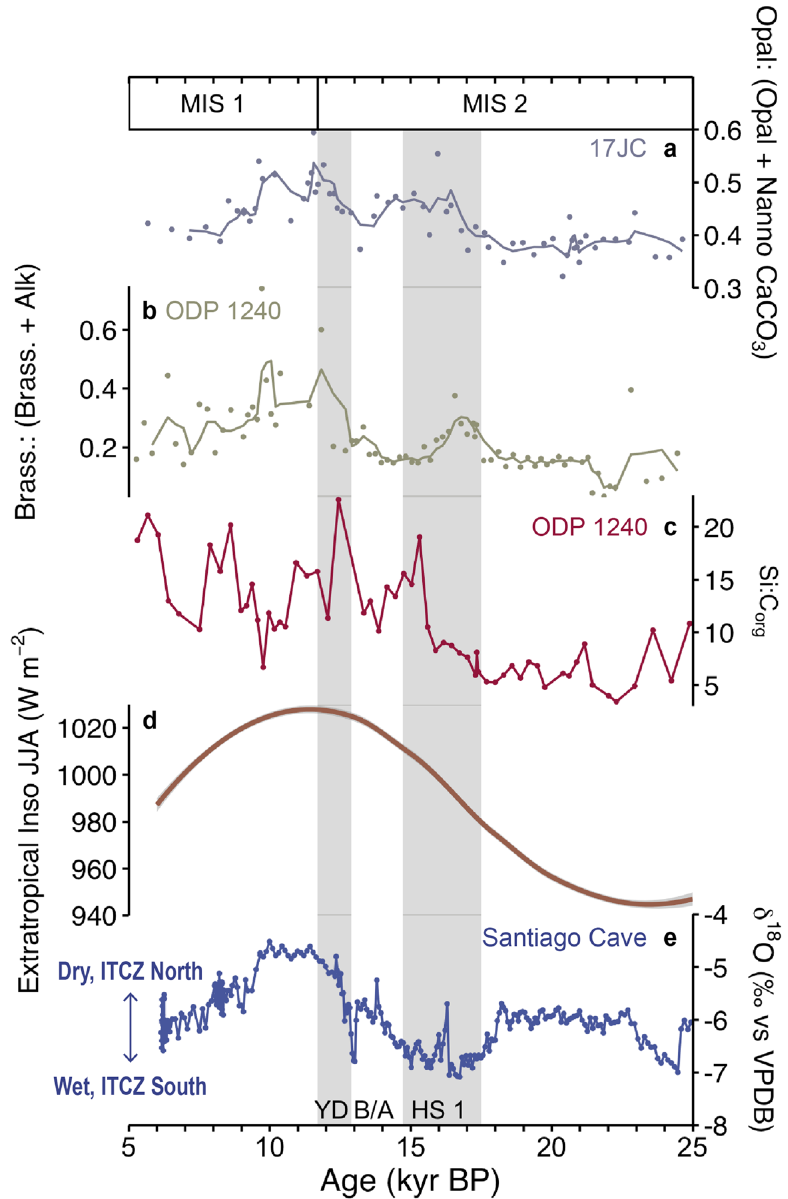
Figure 4. Comparison of phytoplankton community structure shift in the EEP with variability in boreal summer extratropical insolation contrast and ITCZ position over the past 25 kyr. ( a ) 17JC Opal: (Opal + Nannofossil Carbonate) ratios (see “Methods”). The line through the data points represents a three-point running mean. ( b ) ODP 1240 brassicasterol: (brassicasterol + alkenone) ratios 14 . The line through the data points represents a three-point running mean. ( c ) ODP 1240 sedimentary silica: organic carbon (Si:C org ) ratios 15 . ( d ) Difference in mean boreal summer insolation between 30° N and 30° S generated in QAnalyseries 71 based on solutions from Laskar et al. 72 and plotted as the local polynomial regression fitting (loess) of the data with grey 2-sigma error window. ( e ) Santiago Cave δ 18 O calcite 13 . MIS boundaries are from Lisiecki and Raymo, 70 and HS1, B/A, and YD boundaries are from McManus et al. 29